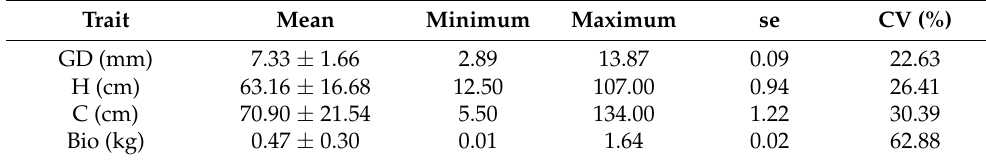
Table 2. Growth trait statistics for B. papyrifera .